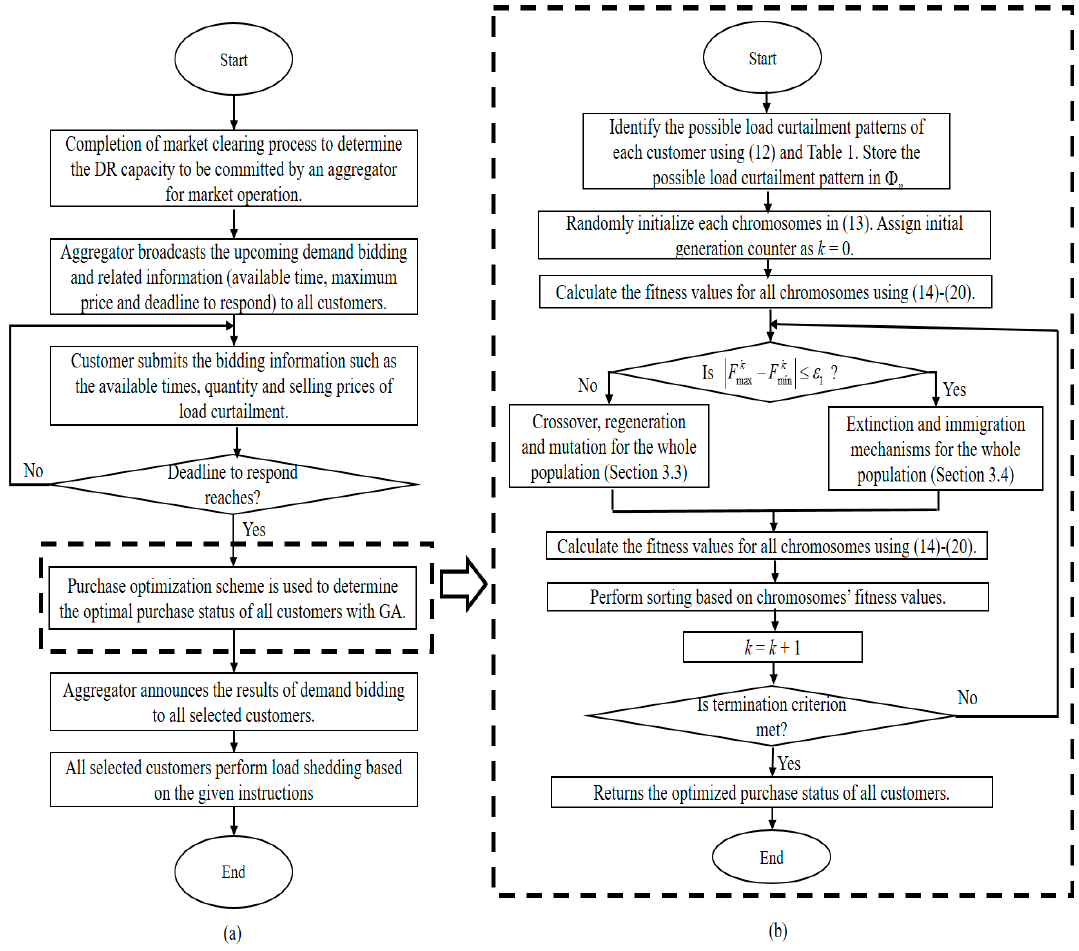
Figure 1. Flowcharts used to describe ( a ) the mechanisms of demand bidding between an aggregator and all customers under its service regions and ( b ) the GA-based purchase optimization scheme used to determine the optimal purchase status of all